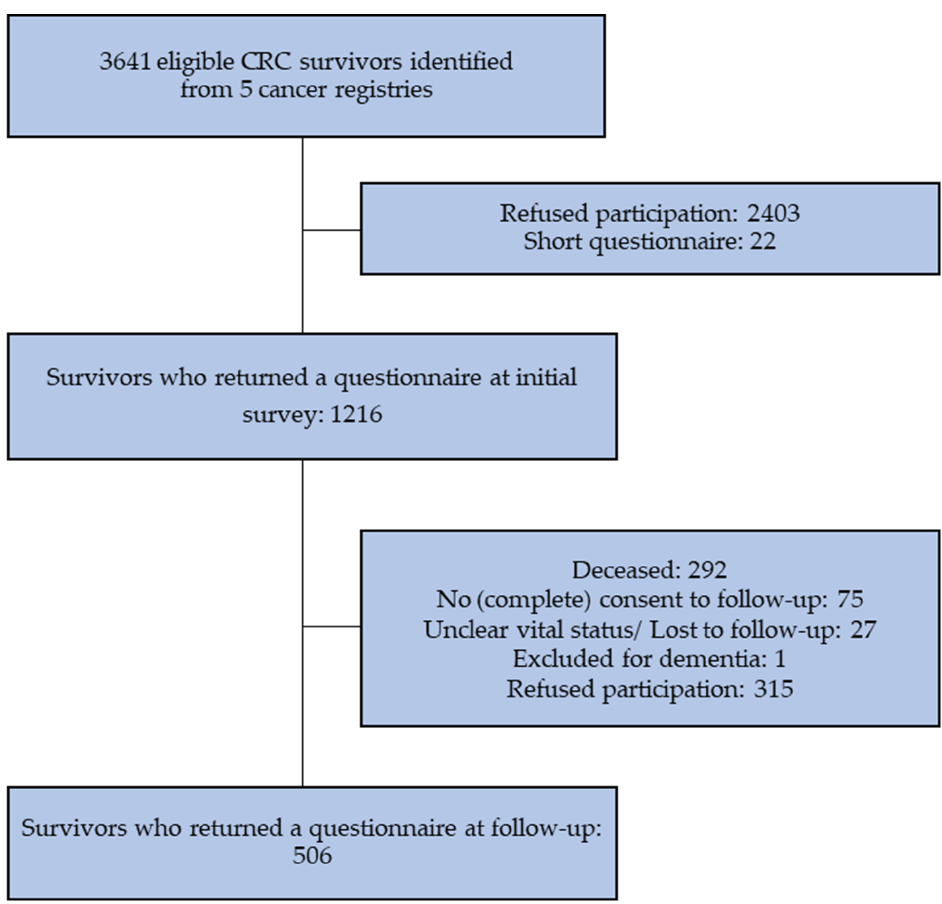
Figure 1. Flowchart of inclusion of CRC survivors.